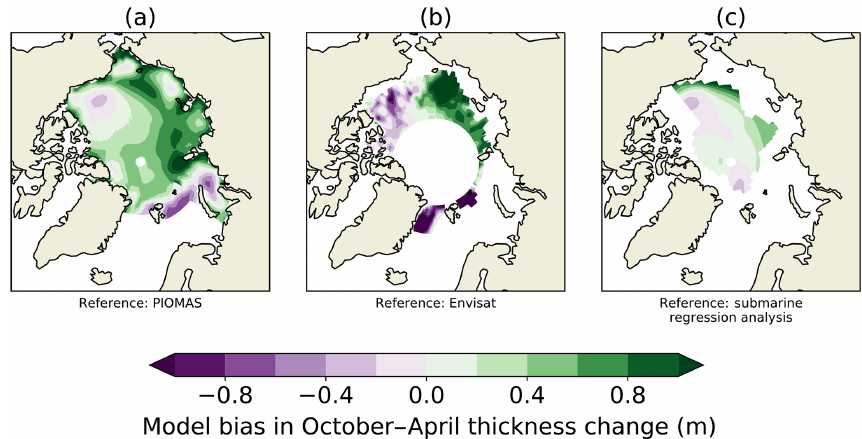
Figure 3. HadGEM2-ES model bias in ice thickness change from October to April compared to (a) PIOMAS 1980–1999, (b) Envisat 1993– 2000 and (c) submarine regression analysis 1980–1999. In each plot, the model period used matches the period of the reference dataset. Differences are taken as model reference so that areas of green (purple) correspond to areas where the HadGEM2-ES model simulates too much (not enough) sea ice growth through the